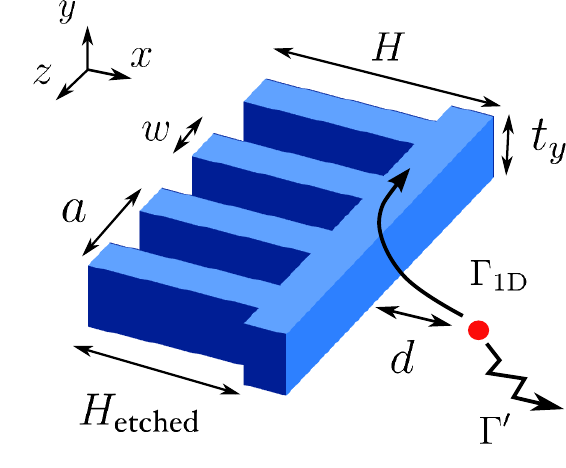
Figure 1. Scheme of the comb waveguide we designed to im- prove the experimental figures of merit of waveguide QED. We optimized the structure so that Rubidium atoms can be trapped in the back of the structure, in a deep potential well ( U trap ∼ 1mK) and at a distance of d = 100nm from the